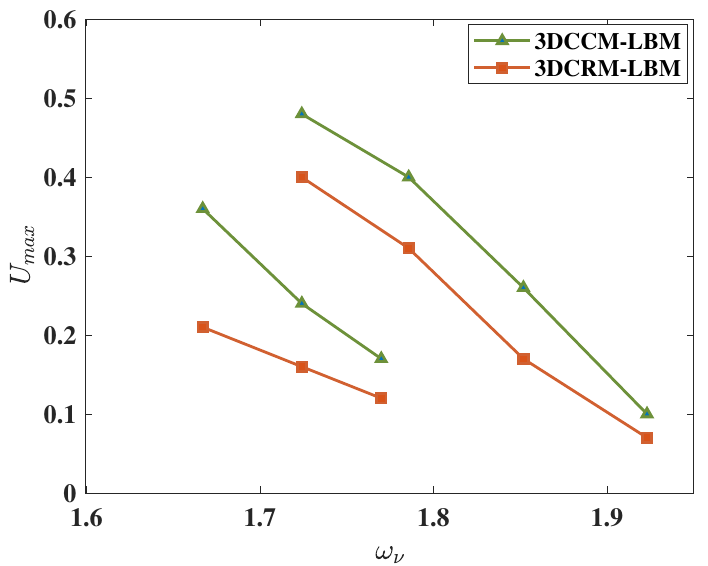
Figure 12. Numerical stability test results showing the maximum threshold velocity of the lid U in a 3D lid driven cubic cavity flow at different values of the relaxation parameter corresponding to the shear viscosity for the 3DCCM-LBM (i.e., based on central moments) and 3DCRM-LBM (i.e., based on central moments) at grid aspect ratios of r = 0.75, s = 1.0 (upper two curves), and r = 0.5, s = 1.0 (lower two